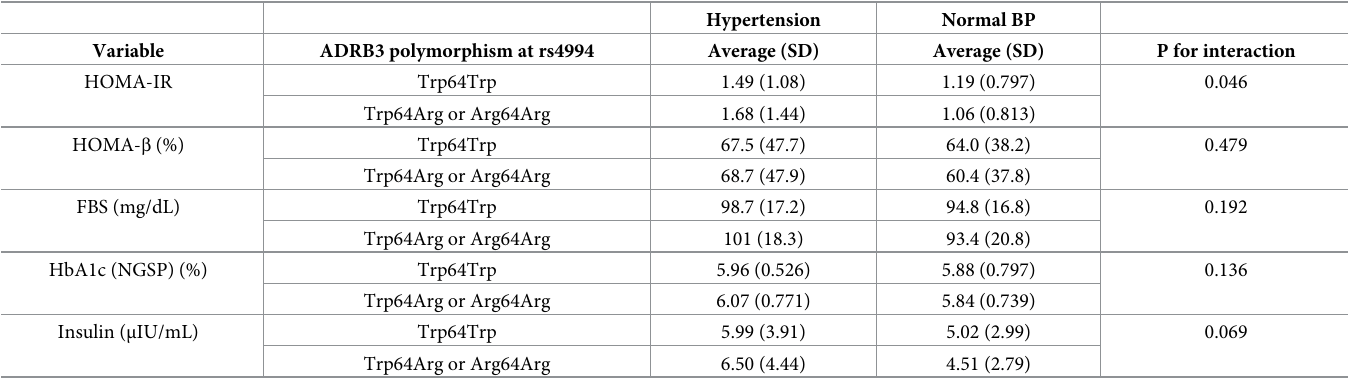
Table 4. Interaction between BP groups and the ADRB3 polymorphism at rs4994.